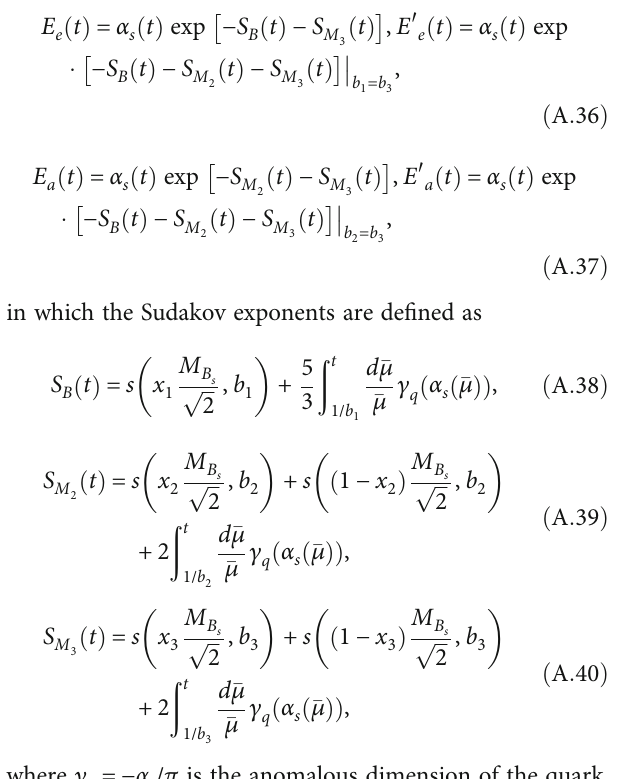
ffiffiffiffiffiffiffiffiffiffiffiffiffiffiffiffiffiffiffiffi x 2 1 − x 3 ð